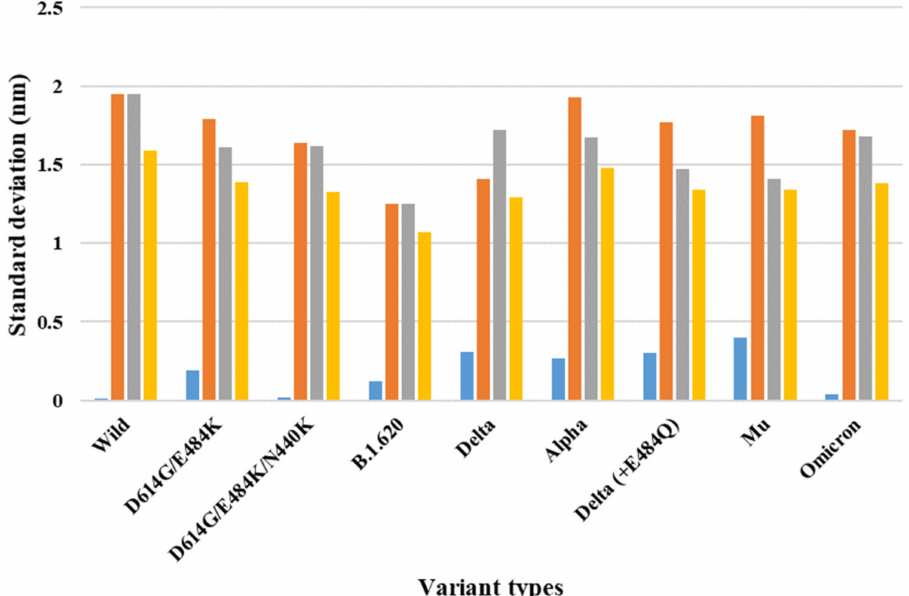
Figure 2. The standard deviation for the distance between V503 residues in each chain for the final MD trajectory in the one-open-complex form (7A94). The X axis denotes variant types, and the Y axis denotes the standard deviation for distance (nm). Blue indicates the standard deviation (SD) between the AB and BC chains, orange indicates the SD between the AB and AC chains, gray indicates the SD between the AC and BC chains, and yellow indicates the SD among the A, B, and C chains.